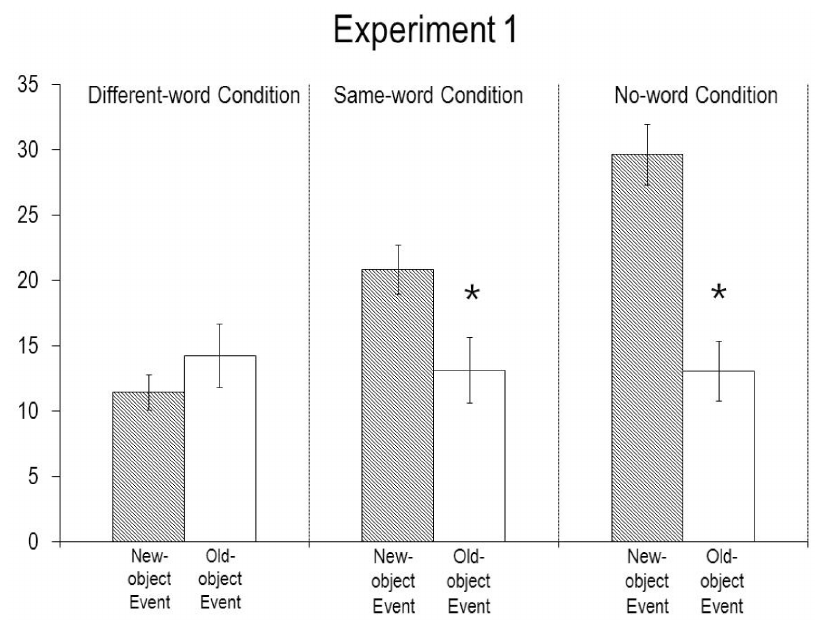
Figure 2. Mean looking times (s) of the infants in Experiment 1 during the test trial. Errors bars represent standard errors, and an asterisk denotes a significant difference between the events within a condition (p , .05 or better).